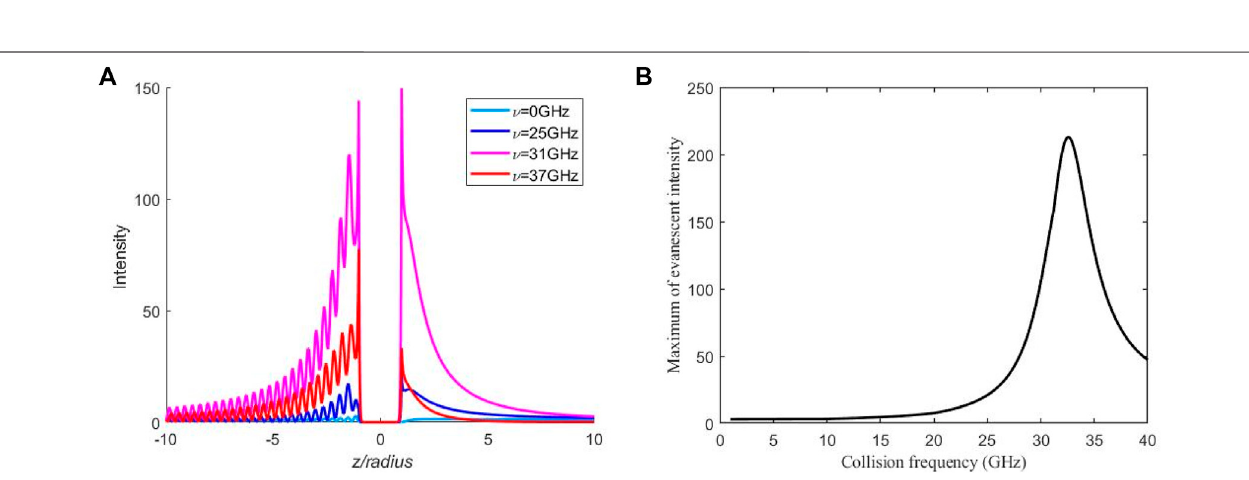
FIGURE 3 | The in fl uence of different collision frequencies on (A) the fi eld distribution and (B) the maximum fi eld of the evanescent wave with f i = 2.1 GHz and f p = 9